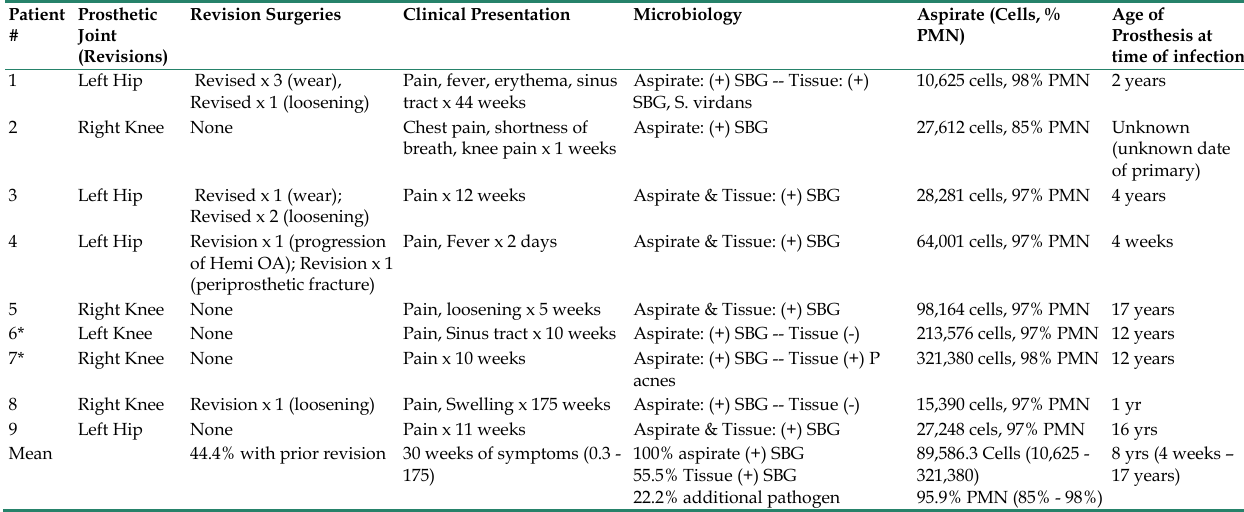
Table 3. Infection data of the current